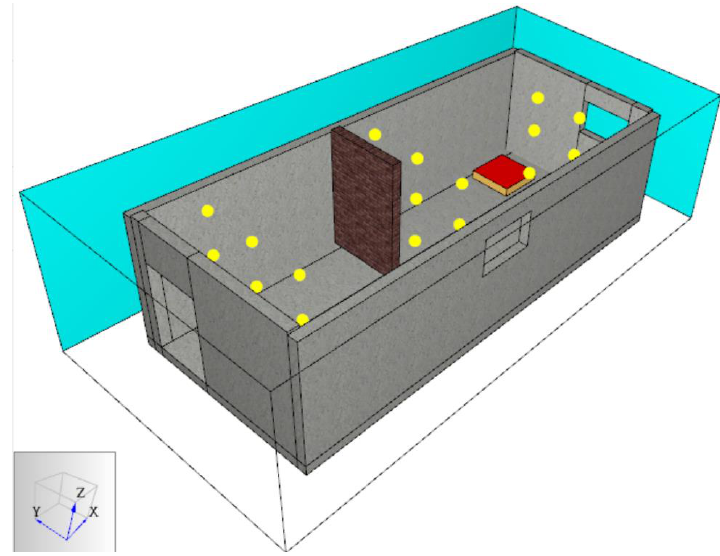
Figure 5. Enclosure model with partition wall and thermocouple trees.